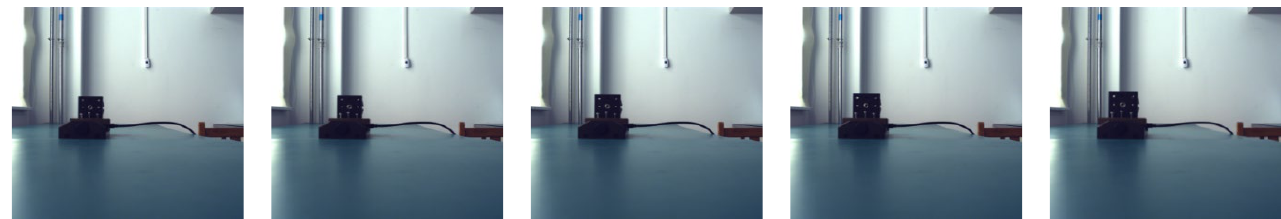
Figure 12. Left view of solid motion image acquisition.